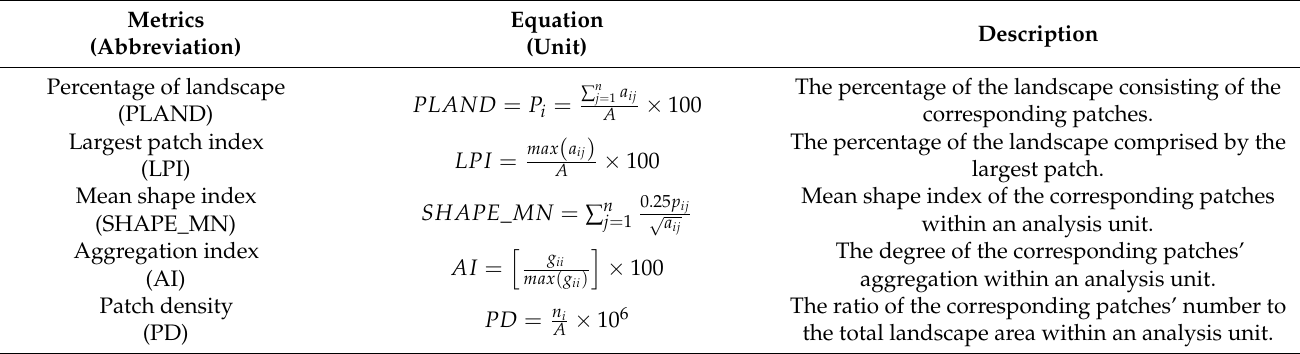
Table 3. Landscape metrics used in this study